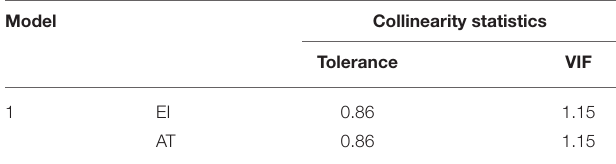
TABLE 6 | Collinearity